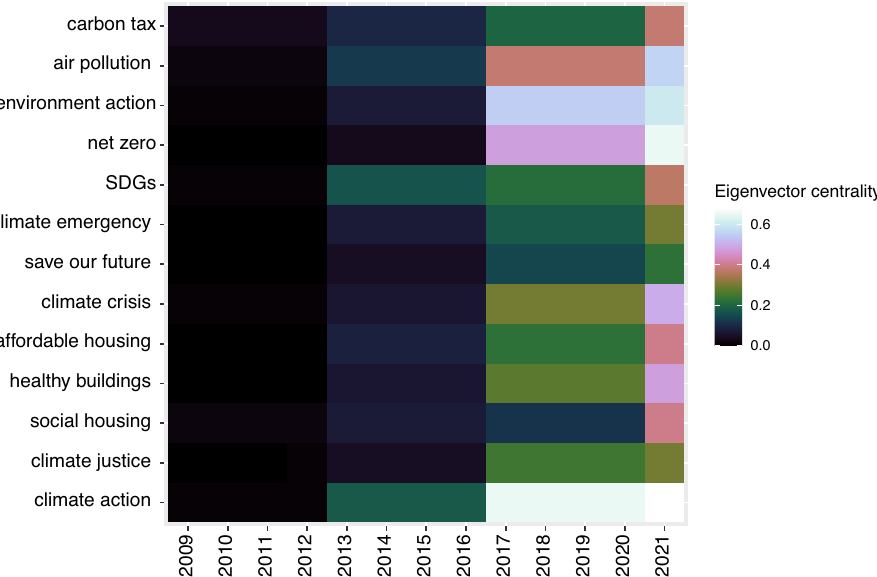
Figure 5. An eigenvector centrality heatmap showing temporal shifts in the online discourse through common social and environmental justice hashtags (#, y-axis) across the 13-year period